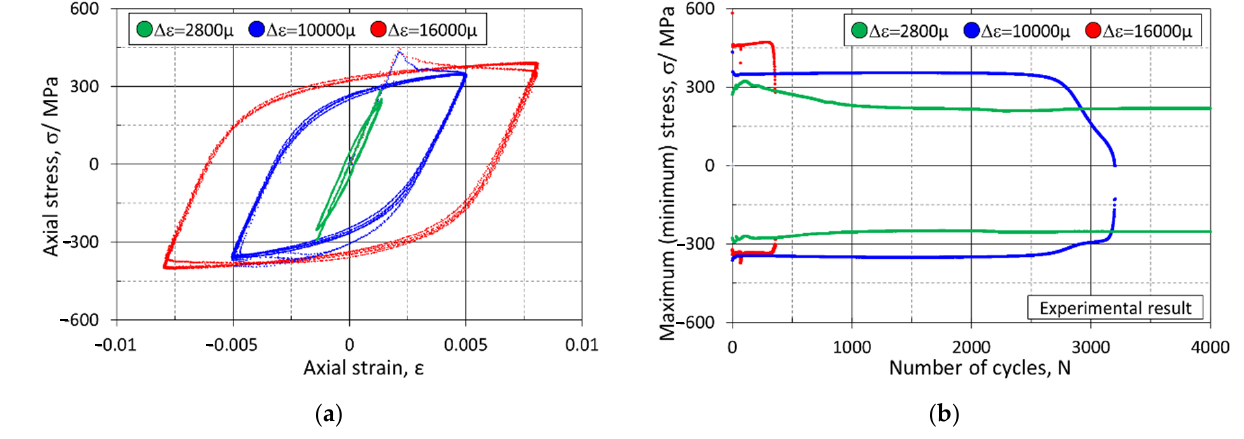
Figure 5. ( a ) Experimental results, axial stress versus axial strain curves under constant strain amplitude loading; ( b ) experimental relationships between σ max- σ min and the number of cycles under constant strain amplitude loading.